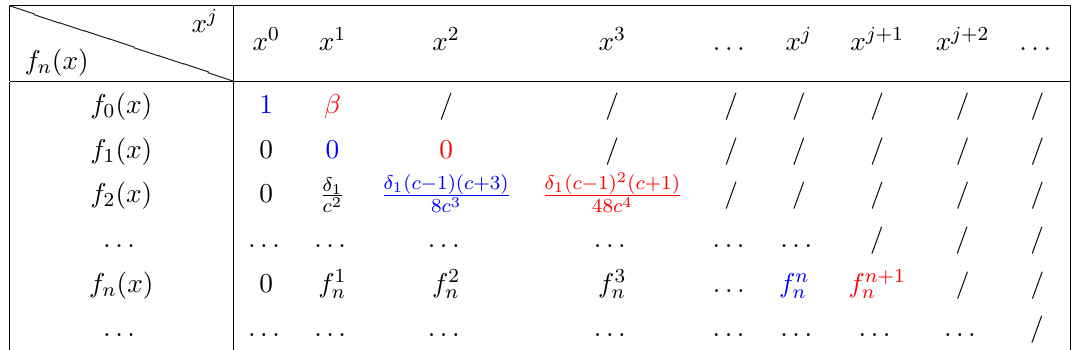
Table 1. Relation between the front interior and leading edge expansion. The function G − 1 resums the red powers in x to all orders, which correspond to leading powers of the f n polynomials, the function G 0 resums the blue terms, the next-to-leading powers, and so forth.